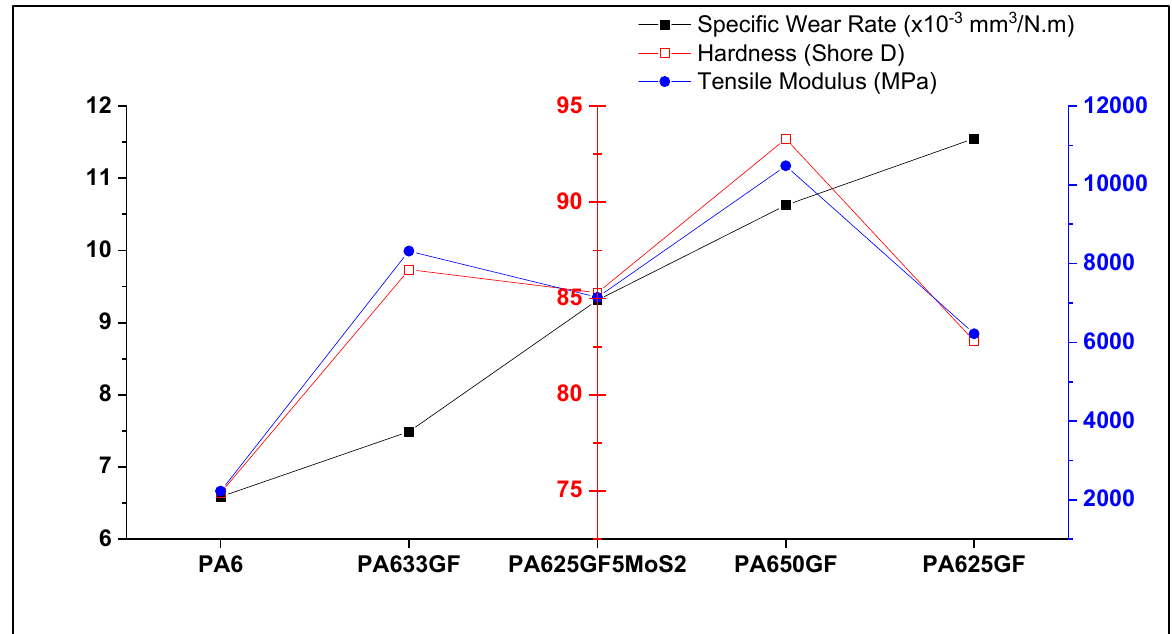
Figure 18. Tensile modulus, hardness, and specific wear rate of PA6 and glass fibre reinforced PA6. Table 7. Comparative analysis between the results of the current study and the relevant studies from the literature survey.